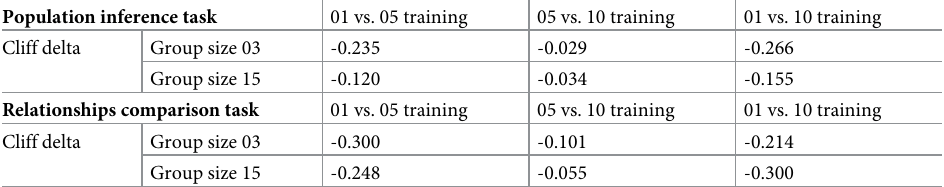
Table 1. Effect size (Cliff’s delta) for differences of test accuracy between 1 training and 5 trainings, 5 trainings and 10 trainings, and 1 training and 10 trainings.